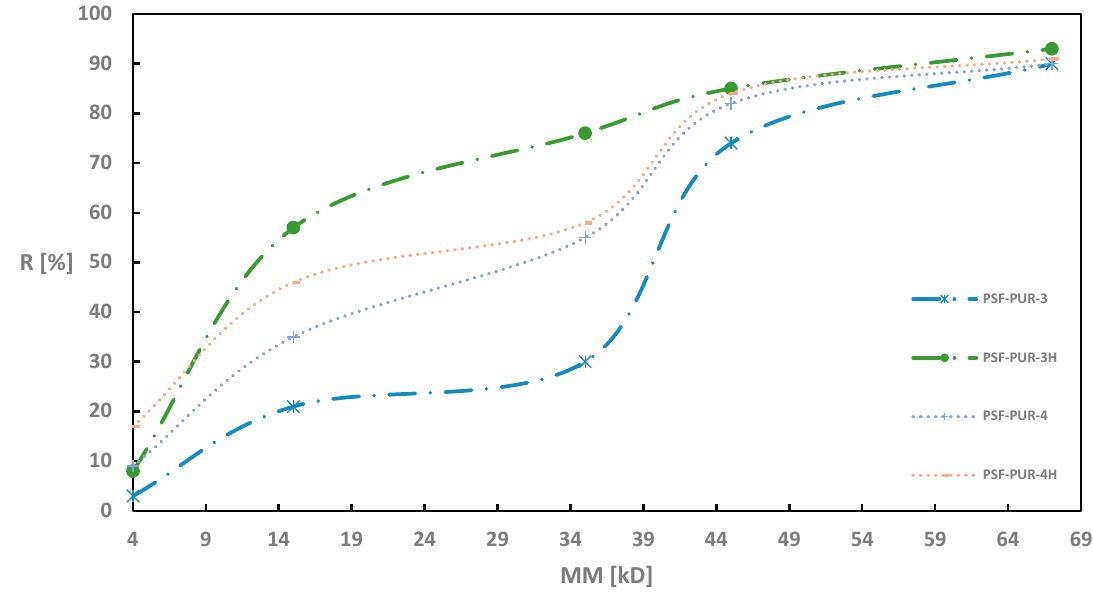
Figure 3. Retention coefficient values for different markers for PSF-PUR-3 and PSF-PUR-4 membranes before (PSF-PUR-3, PSF-PUR-4) and after (PSF-PUR-3H, PSF-PUR-4H) hydrolysis.